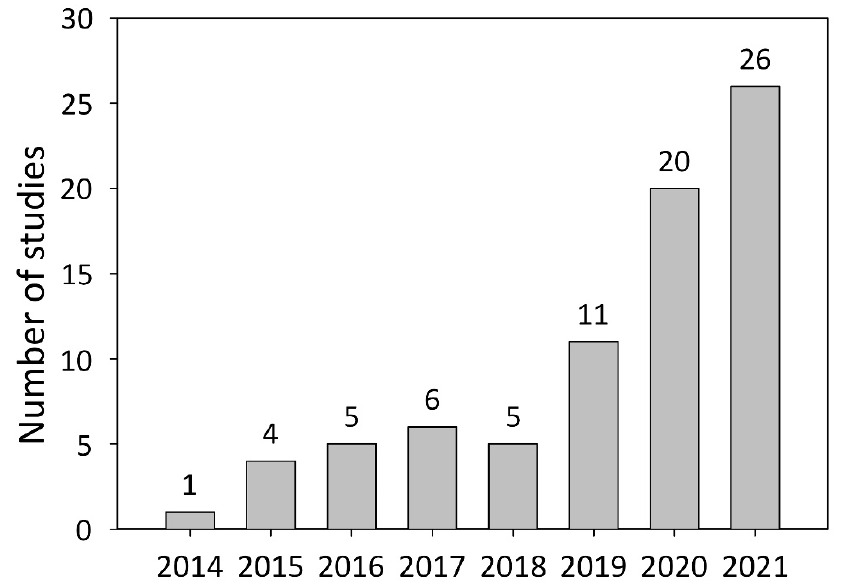
Figure 7. Number of studies on CRISPR/Cas9 genome editing in hairy roots (analyzed on the 13 December 2021). Histogram is based on the Google-search of studies presented in Table S1.